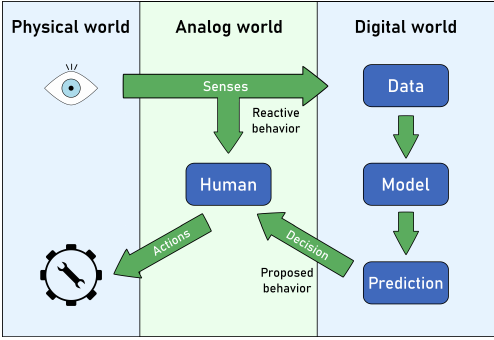
Figure 1. Scheme of the proposed digital twin